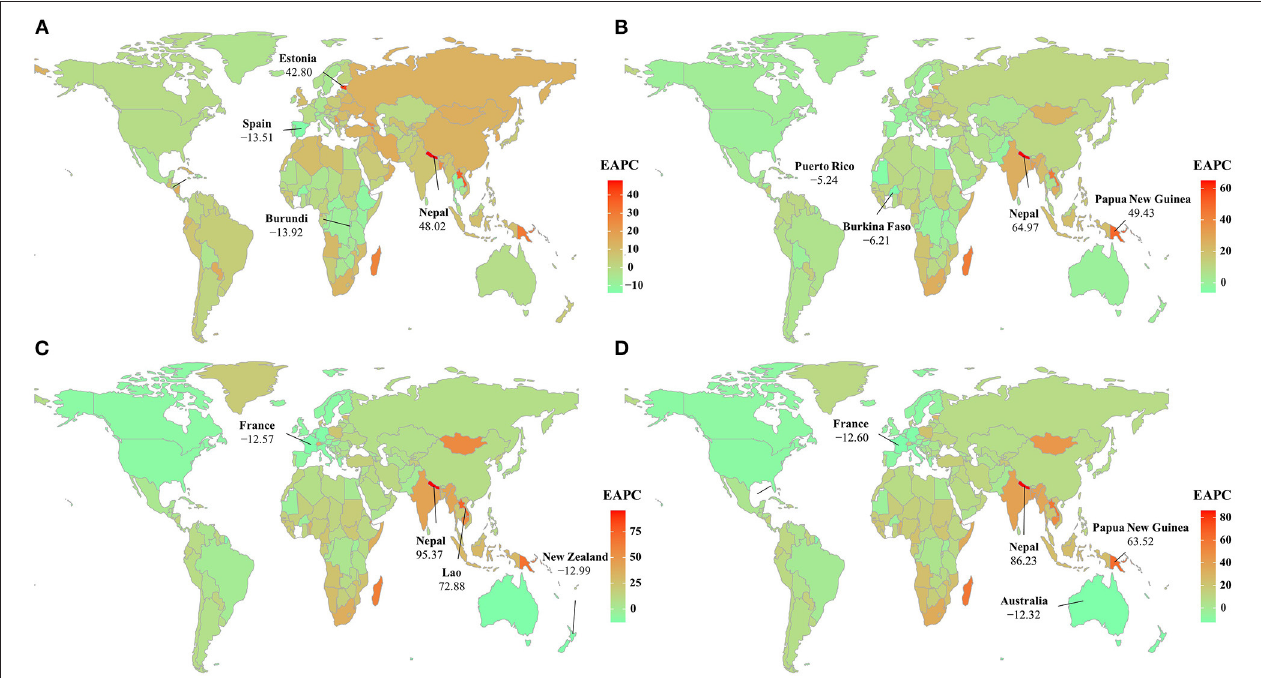
FIGURE 2 | The distribution of the EAPCs of HIV/AIDS burden at the national level during the period 1990–2004, including the incidence (A) , prevalence (B) , deaths (C) , and DALYs (D) . Countries/territories with extreme values are annotated. ASR, age-standardized rate; EAPC, estimated annual percentage change; DALYs, disability-adjusted life